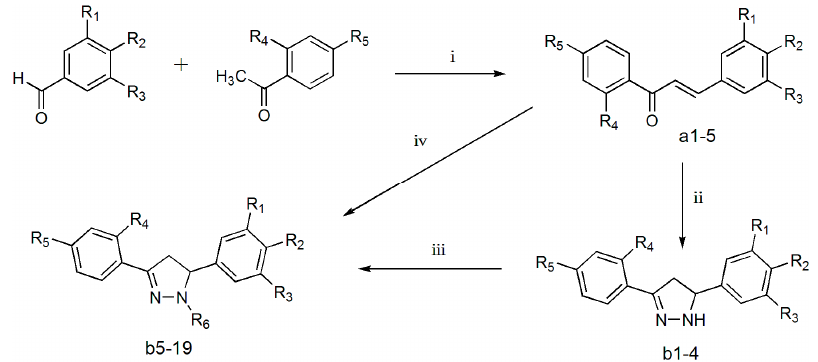
Table 1. Structure of the compounds a1 – 5 .